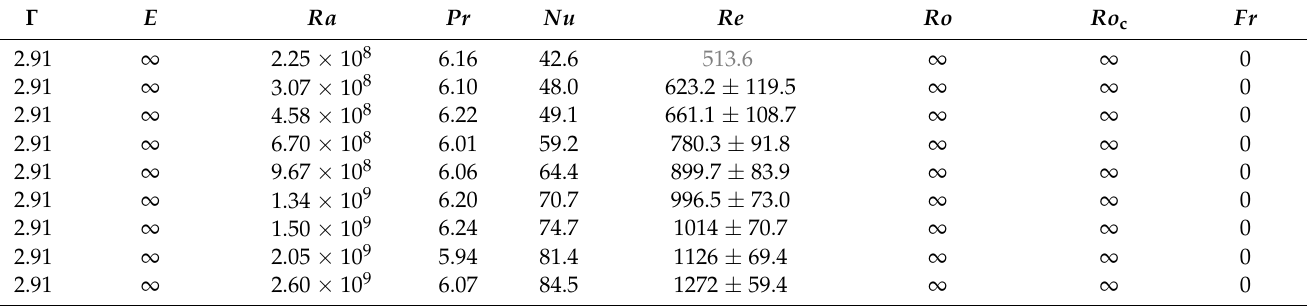
Table A2. Non-dimensional experimental values: Γ is the aspect ratio of the cylindrical container used, E is the Ekman number, Ra is the Rayleigh number, Pr is the Prandtl number, Nu is the Nusselt number, Re is the Reynolds number, Ro is the Rossby Number, Ro c is the convective Rossby number given as Ro c = √ RaE 2 / Pr , and Fr is the Froude number. The dashed horizontal lines separate the different aspect ratio containers used. Re and Ro values that are gray coincide with velocity measurements below the determined resolution limit of 2.5 mm/s for the LDV